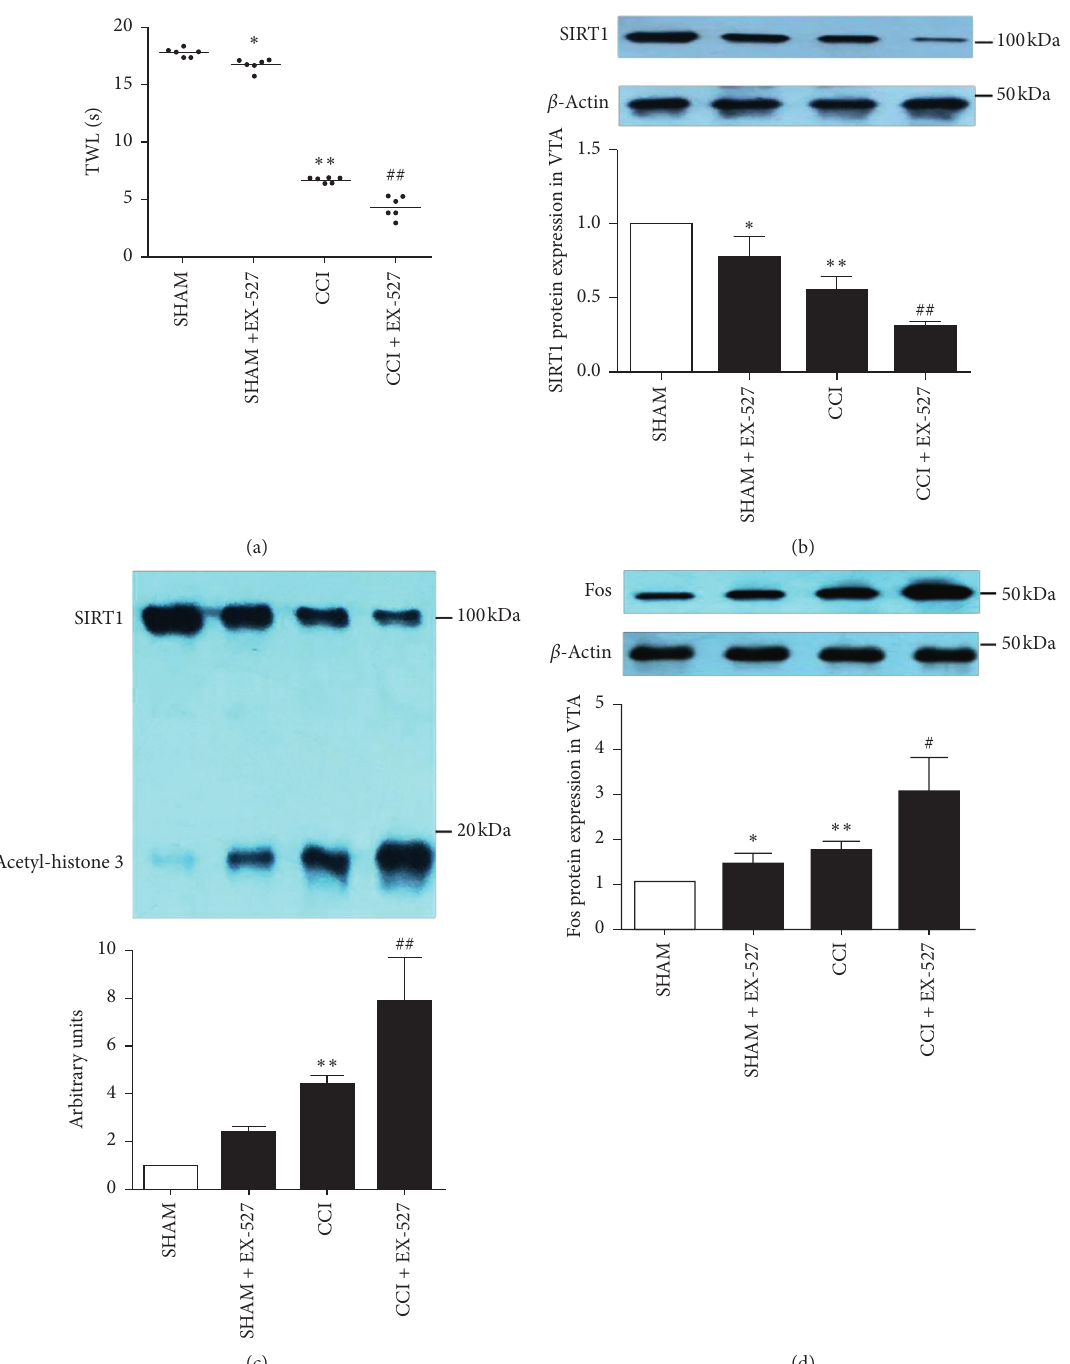
Figure 4: Effects of EX-527 on pain behavior and VTA neuronal activation in CCI mice. EX-527 significantly reduced the TWL in sham- operated mice and further reduced the TWL in CCI mice (a). The expression of SIRT1 in the contralateral VTA of sham-operated and CCI mice was inhibited by EX-527 (b). The level of acetyl-histone 3 in the contralateral VTA of sham-operated and CCI mice was increased by EX-527 (c). The expression of Fos in the contralateral VTA of sham-operated and CCI mice was upregulated by EX-527 (d). Data are presented as mean ± SD. n � 6 mice per group ( n � 3 in the coimmunoprecipitation experiment). ∗ P < 0 . 05, ∗∗ P < 0 . 01 versus the sham- operated group, # P < 0 . 05, and ## P < 0 . 01 versus the CCI